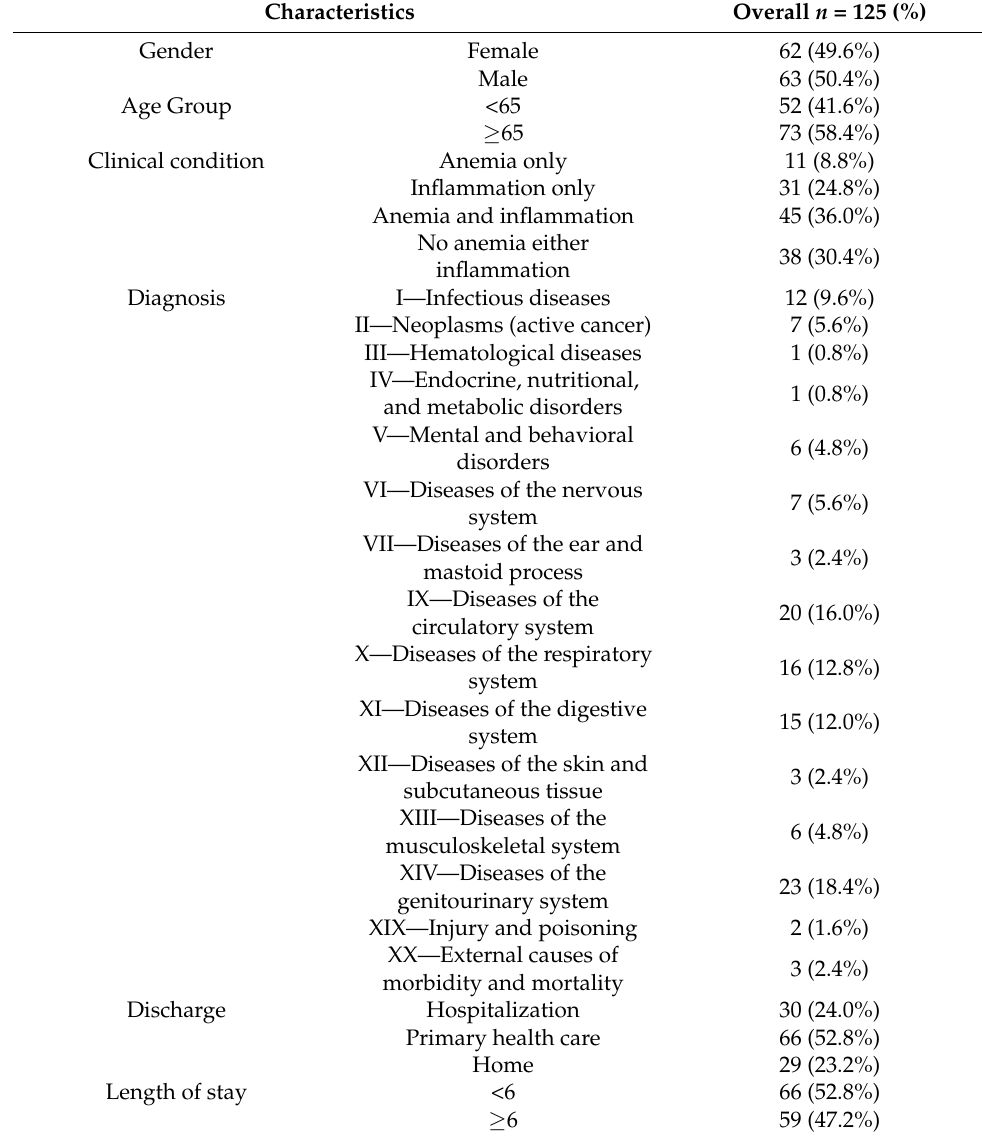
Table 1. Descriptive frequencies of the studied